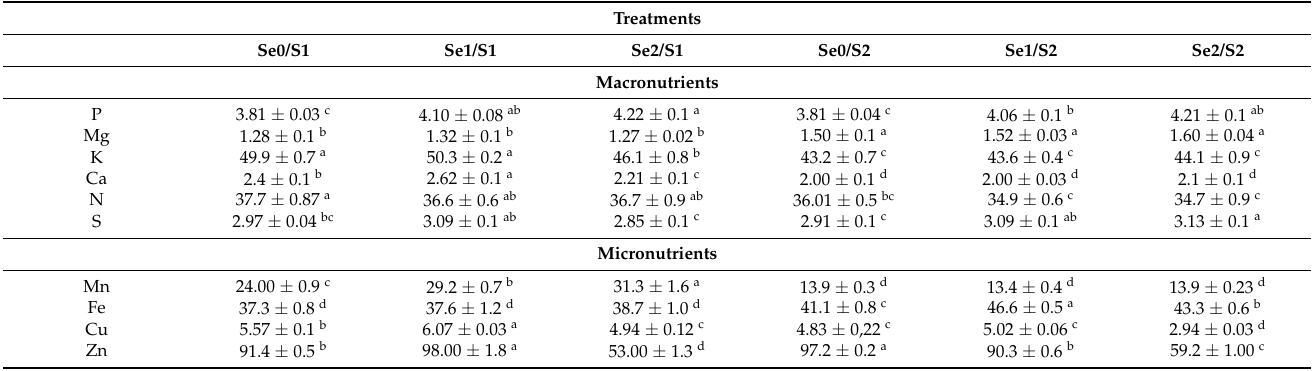
Table 1. Macronutrients (mg g − 1 DM) and micronutrients ( µ g g − 1 DM) concentrations in the lettuce plants grown in a hydroponic system and treated with two S levels (S1: 1 mM; and S2: 2 mM (K 2 SO 4 )), and three Se levels (Se0: 0 µ M; Se1: 1.3 µ M; and Se2: 3.8 µ M (Na 2 SeO 4 )).